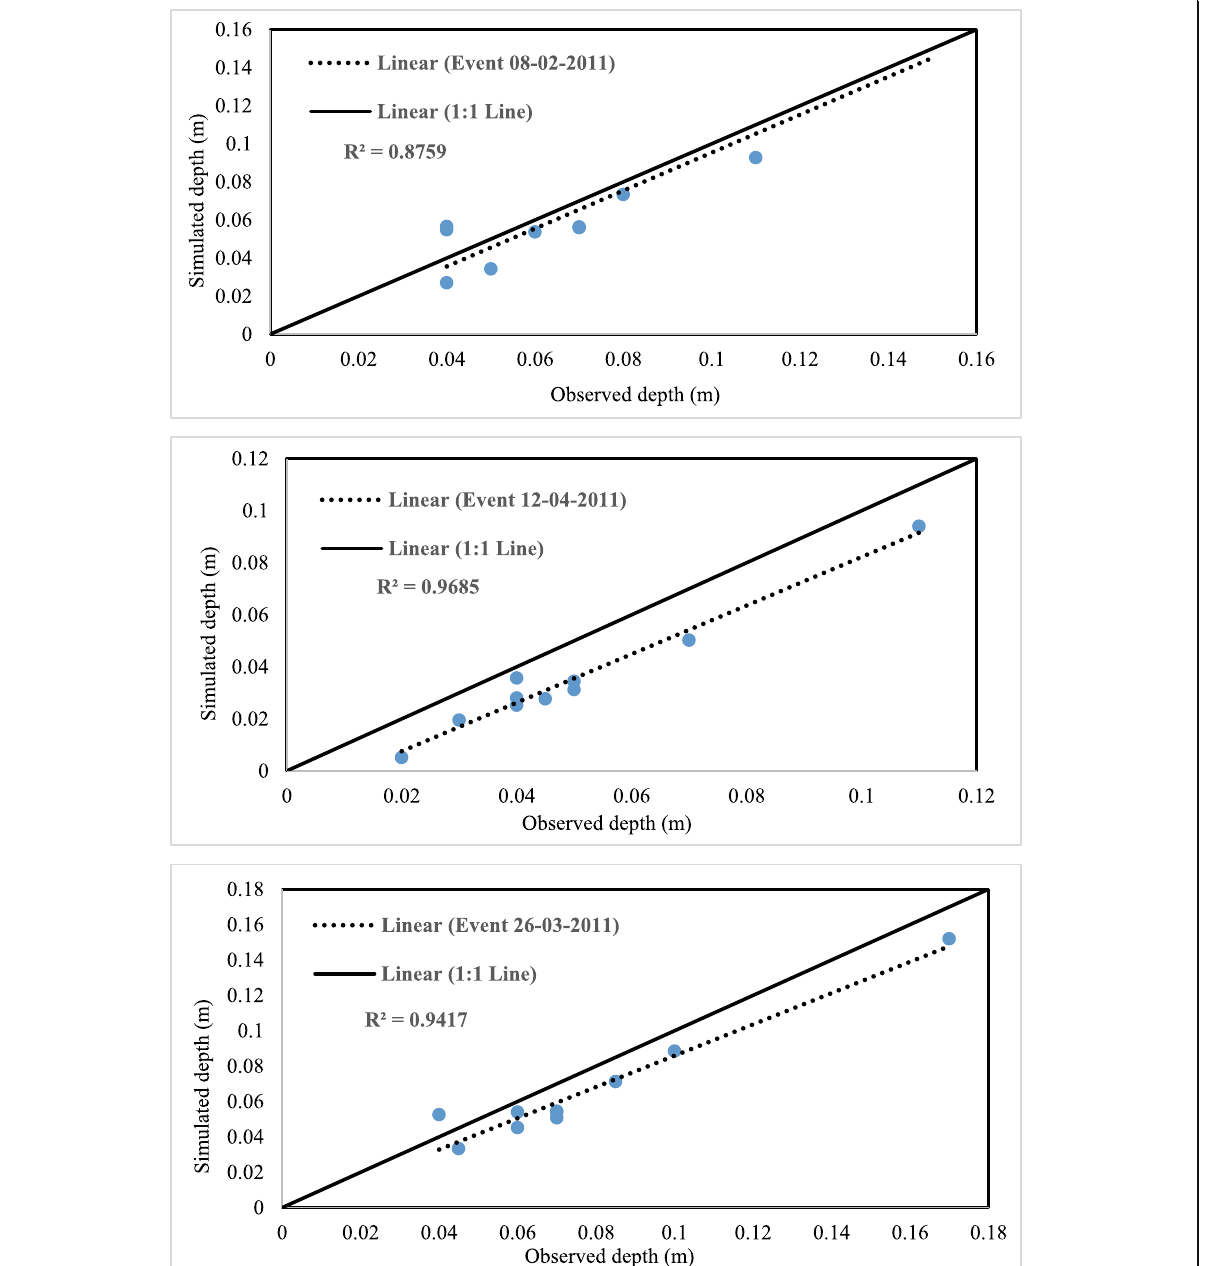
Fig. 7 Scatter plot of observed inundation depth versus simulated inundation depth by